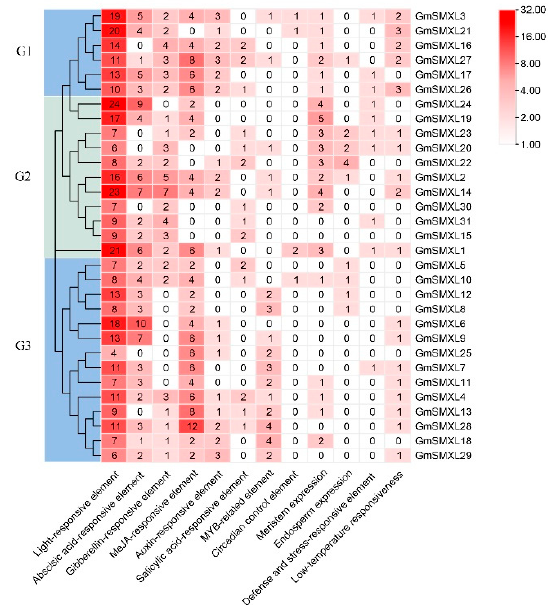
Figure 7. Cis-elements in the GmSMXL genes promoter regions. The number of cis-elements is displayed by the heat map. The redder the color, the more the number of cis-elements. The number represents the specific number of cis-elements of the gene.